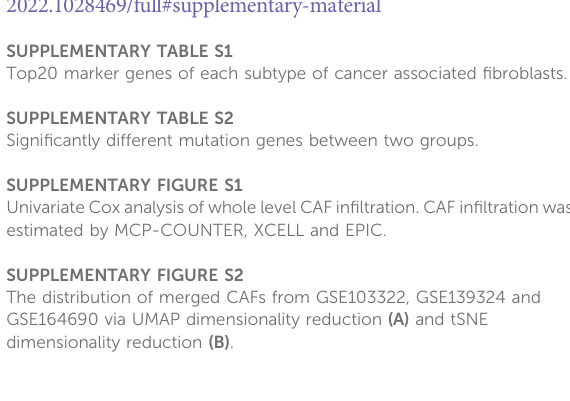
SUPPLEMENTARY TABLE S1 Top20 marker genes of each subtype of cancer associated fi broblasts. SUPPLEMENTARY TABLE S2 Signi fi cantly different mutation genes between two groups. SUPPLEMENTARY FIGURE S1 UnivariateCox analysisof whole level CAFin fi ltration. CAF in fi ltration was estimated by MCP-COUNTER, XCELL and